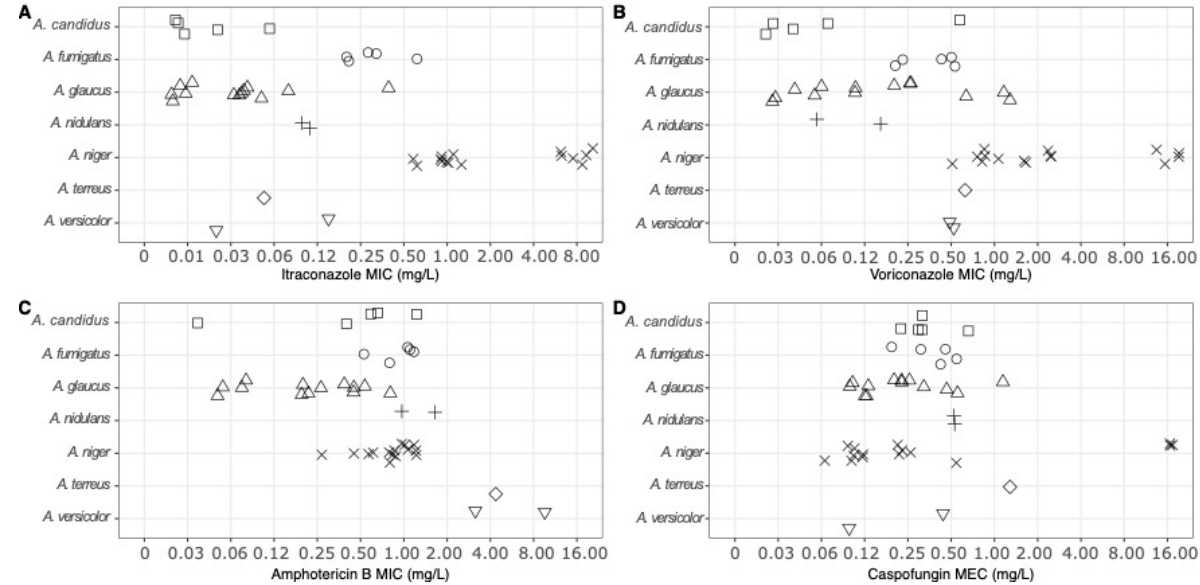
Figure 2. The minimum inhibitory concentration (MIC) and minimum effective concentration (MEC) of each Aspergillus isolate ( n = 43) tested against ( A ) itraconazole, ( B ) voriconazole, ( C ) amphotericin B, and ( D ) caspofungin. Each point represents an individual isolate’s MIC or MEC to the tested antifungal. The different symbols represent the different species of Aspergillus (squares: A. candidus ; circles: A. fumigatus ; triangles: A. glaucus ; crosses: A. nidulans ; crosses: A. niger ; diamonds: A. terreus ; inverted triangles : A. versicolor ).